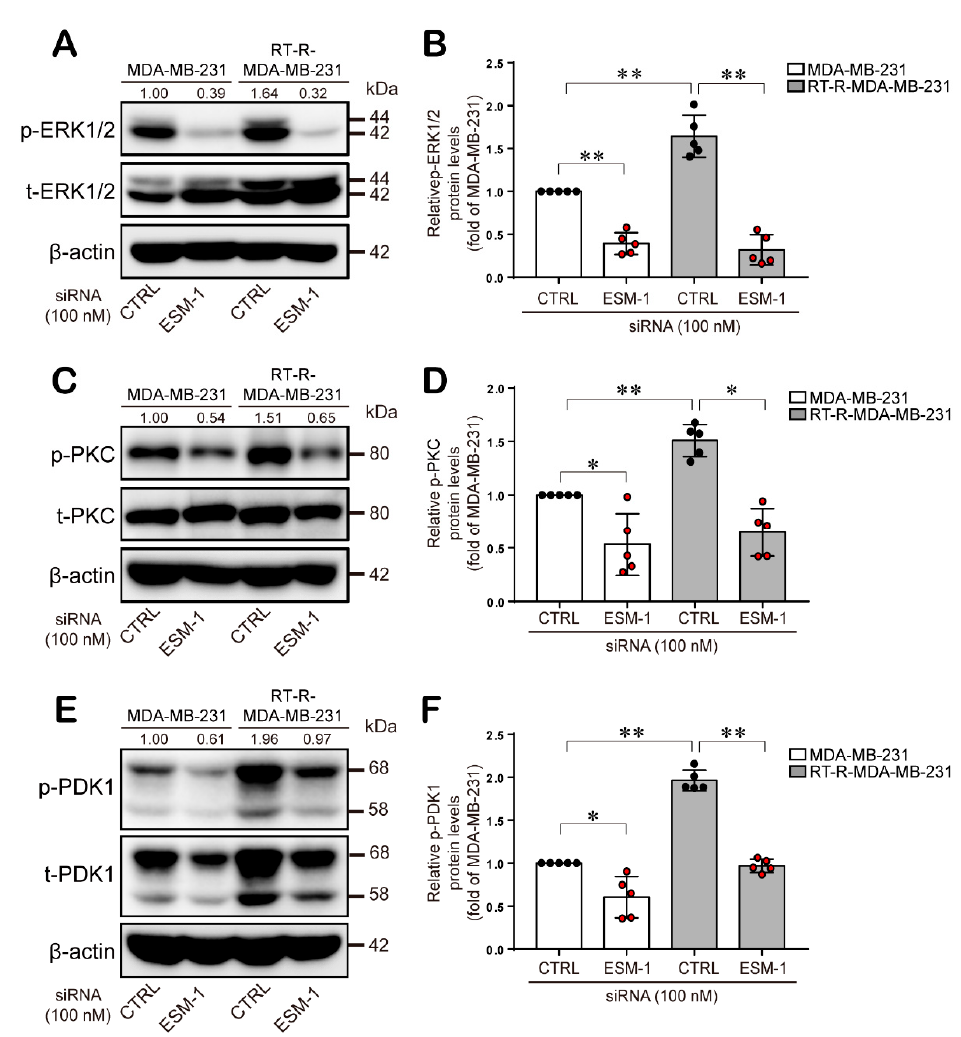
Figure 4. ERK1 / 2, PKC, and PDK1 phosphorylation are enhanced in RT-R-MDA-MB-231 cells compared to MDA-MB-231 cells and are suppressed by knockdown of ESM-1. Cell lysates were obtained from the CTRL- or ESM-1 siRNA-transfected cells, and western blotting was performed to detect the expressions of phospho-ERK1 / 2 / ERK1 / 2 ( A ), phospho-PKC / PKC ( C ), and phospho-PDK1 / PDK1 ( E ). Band densities were quantified, and the relative protein levels are presented as the mean ± SD of five independent experiments ( B , D , F ). * p < 0.05, ** p < 0.01. The full blot images can be found in Figure